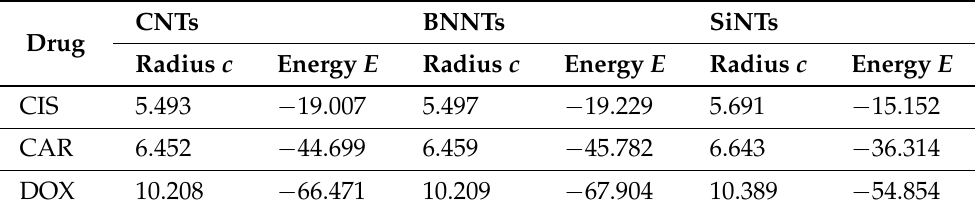
Table 3. Comparison of the values of radius ( c Å) and minimum energy ( E kcal/mol) for the interactions of three drugs inside CNTs, BNNTs, and